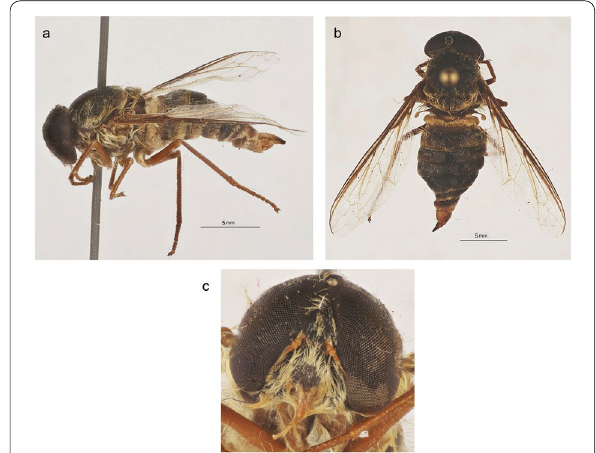
Fig. 4 Trichopsidea costata (Loew, 1858) male. a Habitus, lateral. b Same, dorsal. c Head,